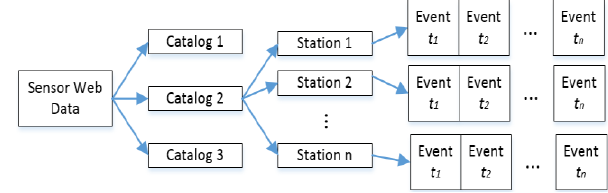
Figure 4: NMStream architecture